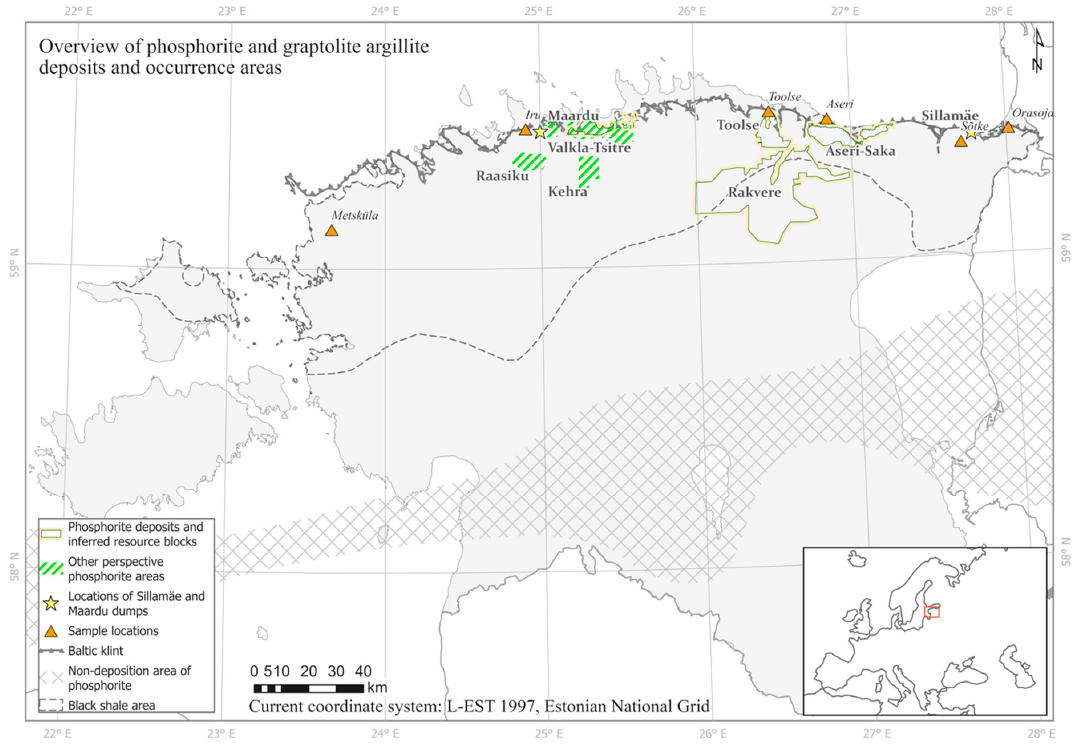
Figure 1. Overview of phosphorite and graptolite argillite (black shale) deposits, occurrence areas and other sites of interest.